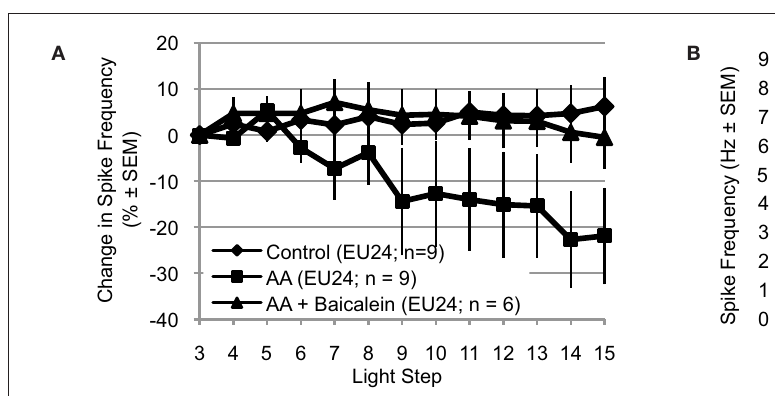
photoreceptors from untrained Hermissenda , MK-886 and baicalein did not affect light-evoked spike frequency during the 3rd light step. Right half. For Type B photoreceptors from EU24 Hermissenda , light-evoked spike frequency during the 3rd light step was significantly reduced, relative to that observed in untrained preparations. Baicalein reversed the EU training-related reduction in light-evoked spike